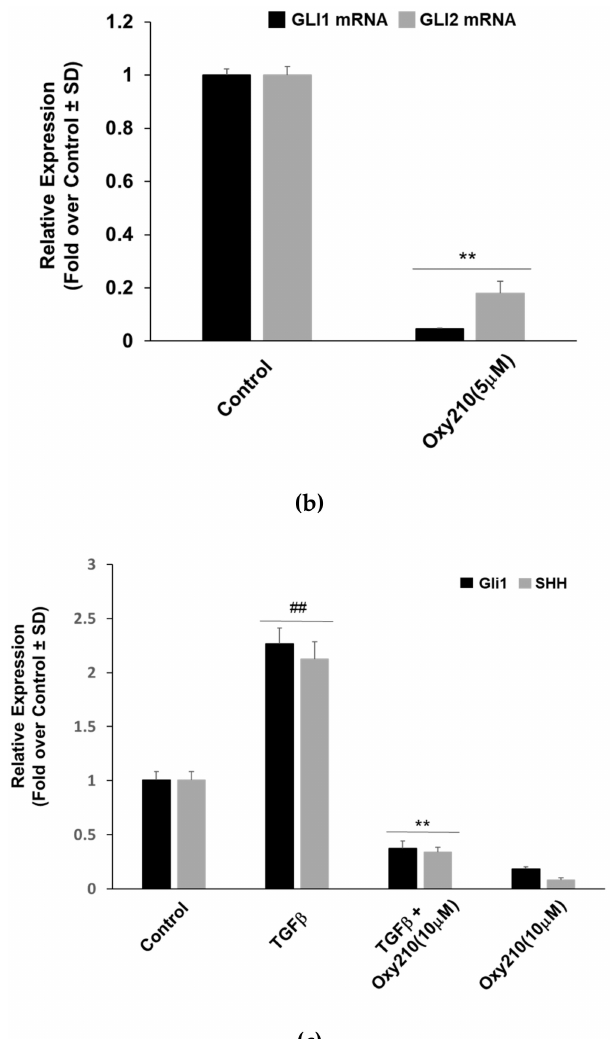
Figure 6. Inhibition of Glis and SHH expression in Non-Small Cell Lung Cancer (NSCLC) cells. A549 ( a ) and H2030 ( b ) cells were treated with Oxy210 in RPMI 1640 containing 5% FBS for 72 h, then RNA was extracted and analyzed by Q-RT-PCR for the expression of the indicated genes and normalized to GAPDH expression. ( c ) A549 cells were pretreated for 2 h with Oxy210 in RPMI 1640 containing 5% FBS. Next, cells were treated with TGF β (10 ng / mL) in the absence or presence of Oxy210. After 48 h, RNA was extracted and analyzed by Q-RT-PCR for the expression of Gli1 and Shh and normalized to GAPDH expression. Data from a representative experiment are reported as the mean of triplicate determinations ± SD (** p < 0.01 vs. TGF β treated cells; ## p < 0.01 vs.